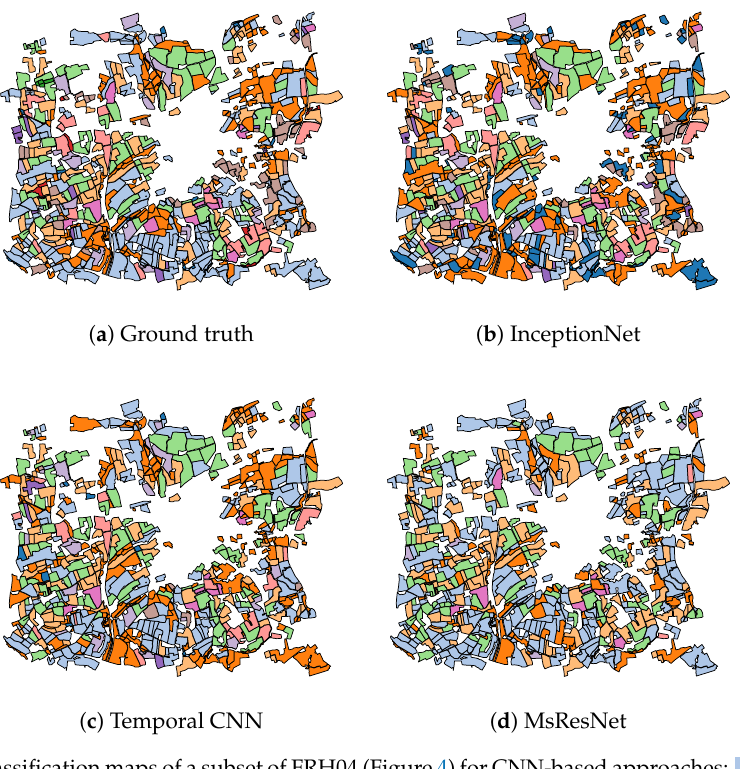
Figure 10. Classification maps of a subset of FRH04 (Figure 4) for CNN-based approaches: